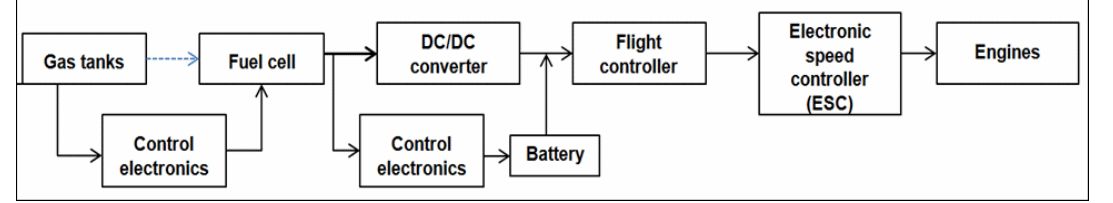
Figure 6. Simplified scheme for the fuel cell-powered UAV.